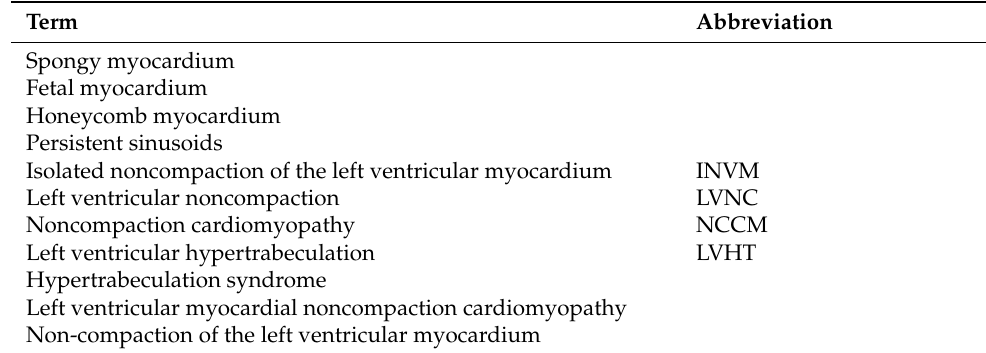
Table 1. A selection of terms and abbreviations for noncompacted cardiomyopathy and the noncom- pacted